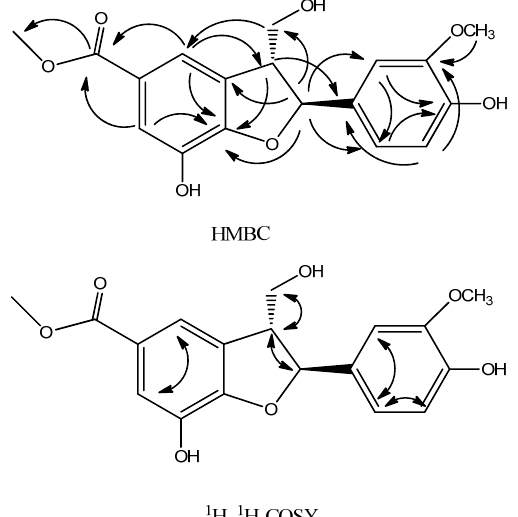
Figure 2. Key HMBC and 1 H, 1 H-COSY correlations of compound 1 .